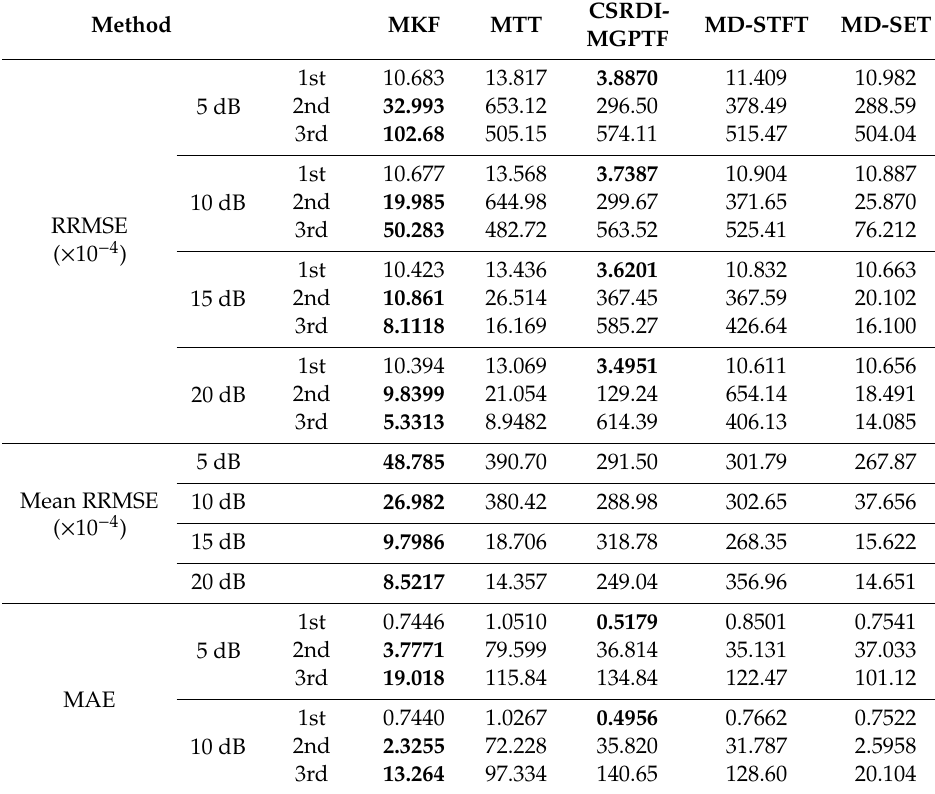
Table 5. Performance evaluation of IF Estimation for example